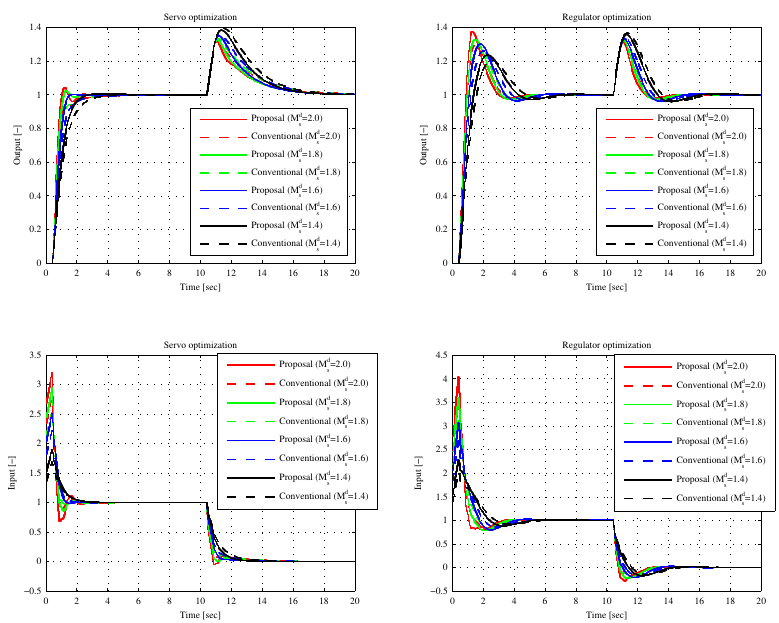
Figure 10. Output and input trajectories for the proposed and conventional designs for Equation (46), where the system is disturbed by a unit step disturbance after 10 s; left: servo optimization; right: regulator